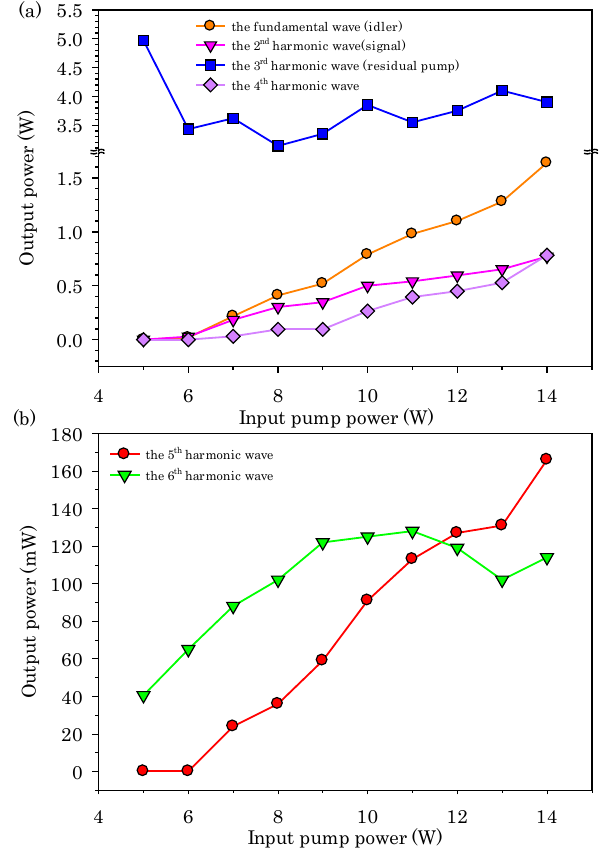
Figure 3. The measured power of the multi-harmonic optical comb after Pellin Broca prism and the dichroic mirror after idler SHG in Figure 1. Here, ( a ) shows the power of the fundamental wave (idler), the 2nd harmonic wave (signal), the 3rd harmonic wave (residual pump power), and the 4th harmonic wave which were generated from the frequency divided-by-three SRO and the intracavity second harmonic generation for the 4th harmonic wave; ( b ) shows the power of 5th harmonic wave and the 6th harmonic wave. The 5th harmonic wave and the 6th harmonic wave are generated from single pass sum frequency generation and second harmonic generation,